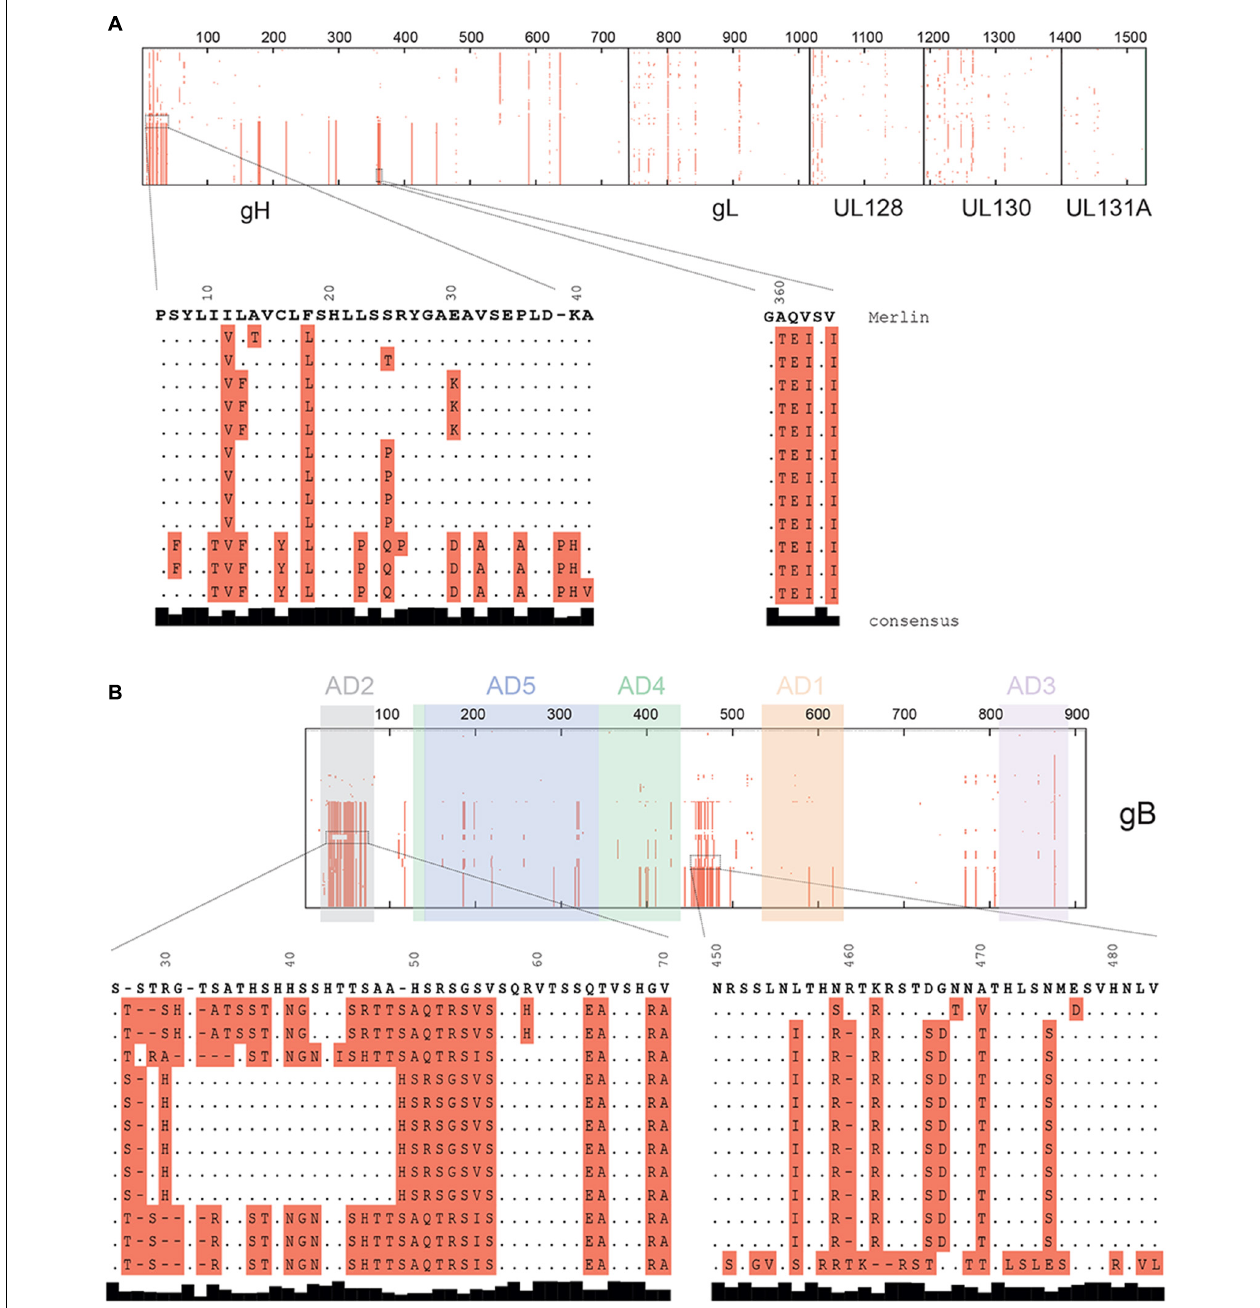
FIGURE 3 | Sequence alignment of the pentamer and gB complexes. Protein sequences were aligned with Clustal (cid:127) . All amino acids different from the reference HCMV strain (Merlin) are highlighted in red. Thick lines inside the aligned sequences represent 100 amino acids. Regions with high sequence diversity are expanded and shown in detail below the pictographic alignment. (A) Protein alignment of concatenated subunits of the pentamer complex (gHgLpUL128pUL130pUL131A). (B) gB protein alignment where AD-2 and Furin cleavage site are expanded. Antigenic domains (AD) are highlighted in different